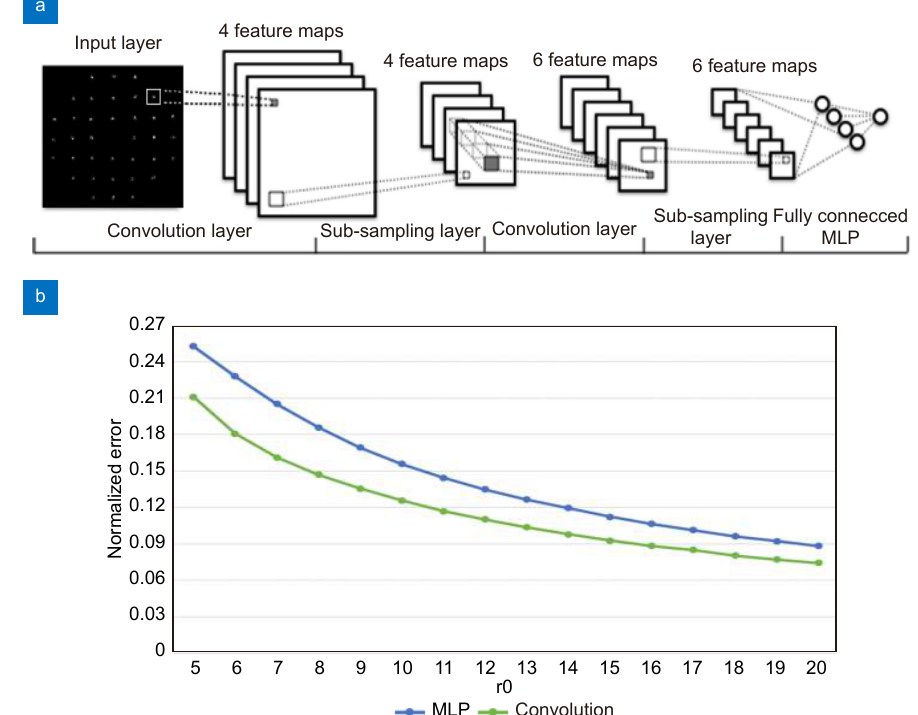
Fig. 5 | ( a ) The architecture of the CNN for SHWFS. The input is a SHWFS image and the output is a vector, which indicates centroids. ( b ) The performance of CNN compared with MLP where the error is calculated as the average of the absolute value of the difference between all the out- put network centroids and the simulated true centroids. Figure reproduced from: (a, b) ref. 74 , International Conference on Hybrid Artificial Intelli- gence Systems.